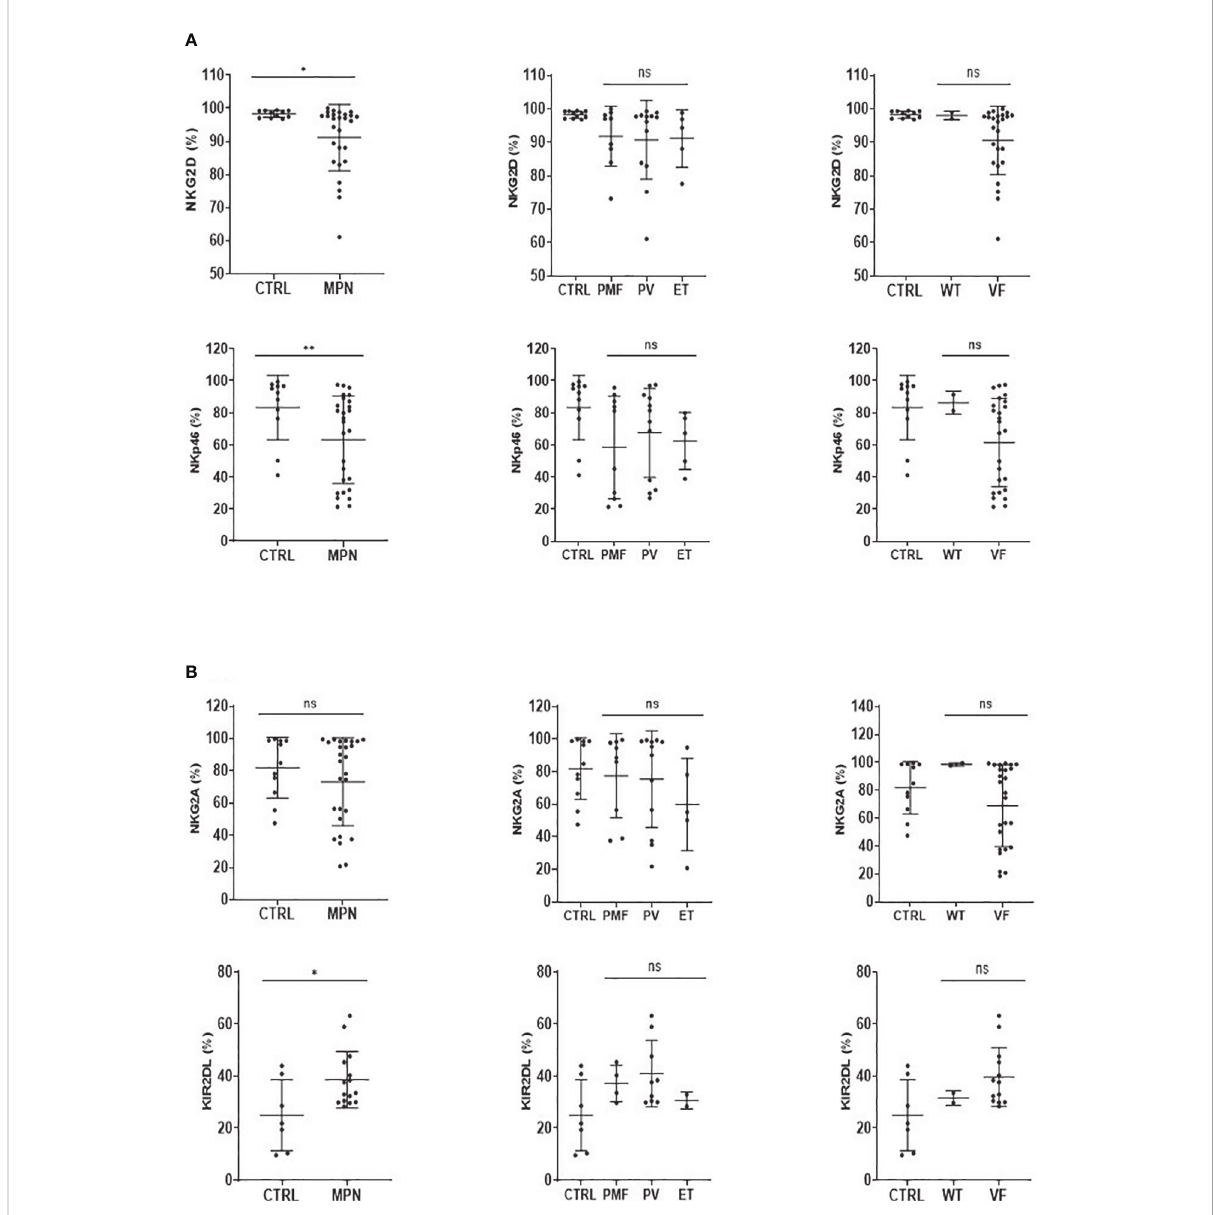
FIGURE 6 NK-cell activatory and inhibitory receptors are imbalanced in MPN patients. The frequency of (A) NK-cell activation (NKG2D, NKp46) and (B) NK-cell inhibition (NKG2A, KIR2DL) receptor cells in myeloproliferative neoplasms with JAK2V617F mutation (VF) or not (WT). CTRL, control; MPN, myeloproliferative neoplasms (n = 27); PV, polycythemia vera (n = 12); ET, essential thrombocythemia (n = 5); PMF, primary Myelo fi brosis (n = 10). Error bars indicate the mean (± SEM). NS, not signi fi cant (p > 0.05); *p < 0.05; **p < 0.01; Mann – Whitney and Kruskal – Wallis